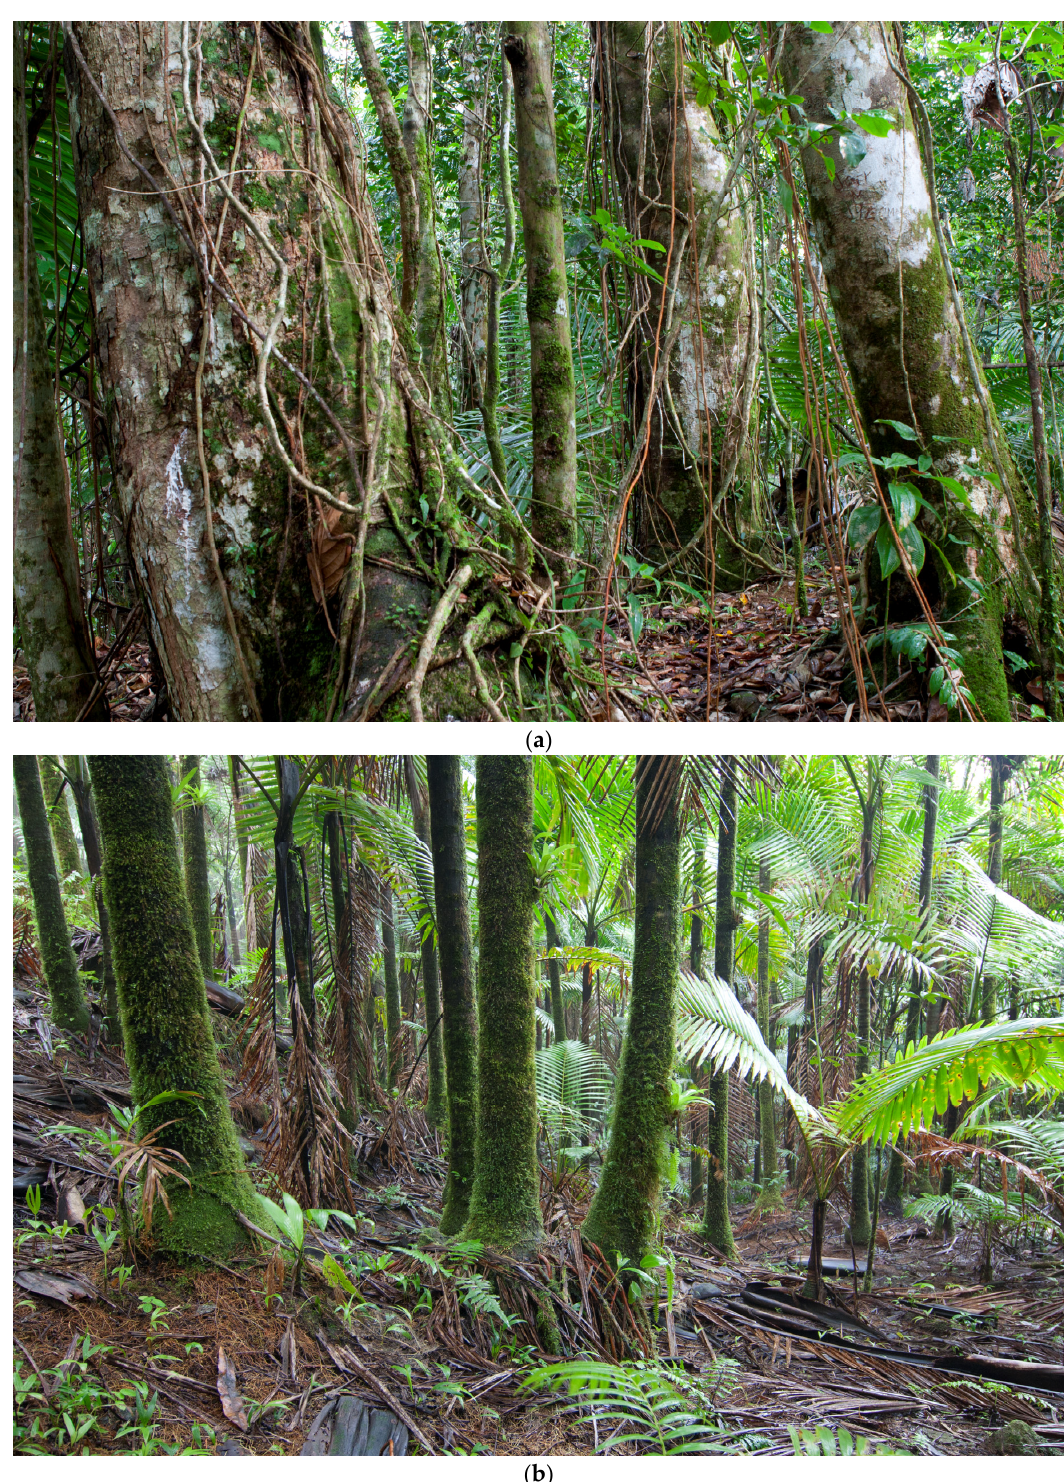
Figure 2. Views of vegetation from the Luquillo Experimental Forest, Puerto Rico. Top panel ( a ) Tabonuco, Dacryodes excelsa , the dominant tree species in forests at lower montane elevations; Bottom panel ( b ) Sierra palm, Prestoea montana , with stems found at all elevations and able to form mono ‐ specific forest stands. Photos by Jerry Bauer.